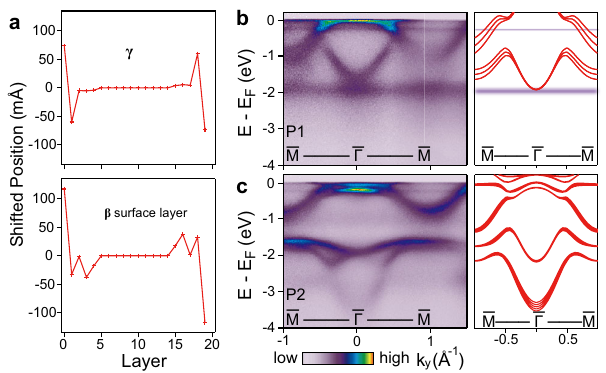
Fig. 6 The electronic transition from P1 to P2. a Out-of-plane structural relaxation of the surface γ or β layers in a 20 atomic-layer Ce slab, whose inner layers are fi xed to be the bulk γ -phase. The shifted positions refer to z positions relative to the expected bulk value. b, c Experimental valence band dispersion (left) of P1 ( b ) and P2 ( c ) along (cid:1) Γ (cid:1) M , in comparison with DFT band structure calculations (right). In the P1 calculation, diffuse cyan lines at E = − 1.9, − 0.25, and 0 eV indicate the lower Hubbard band, the 4 f 1 and 4 f 1 Kondo peaks, similar to Fig. 7 = 2 5 = 2